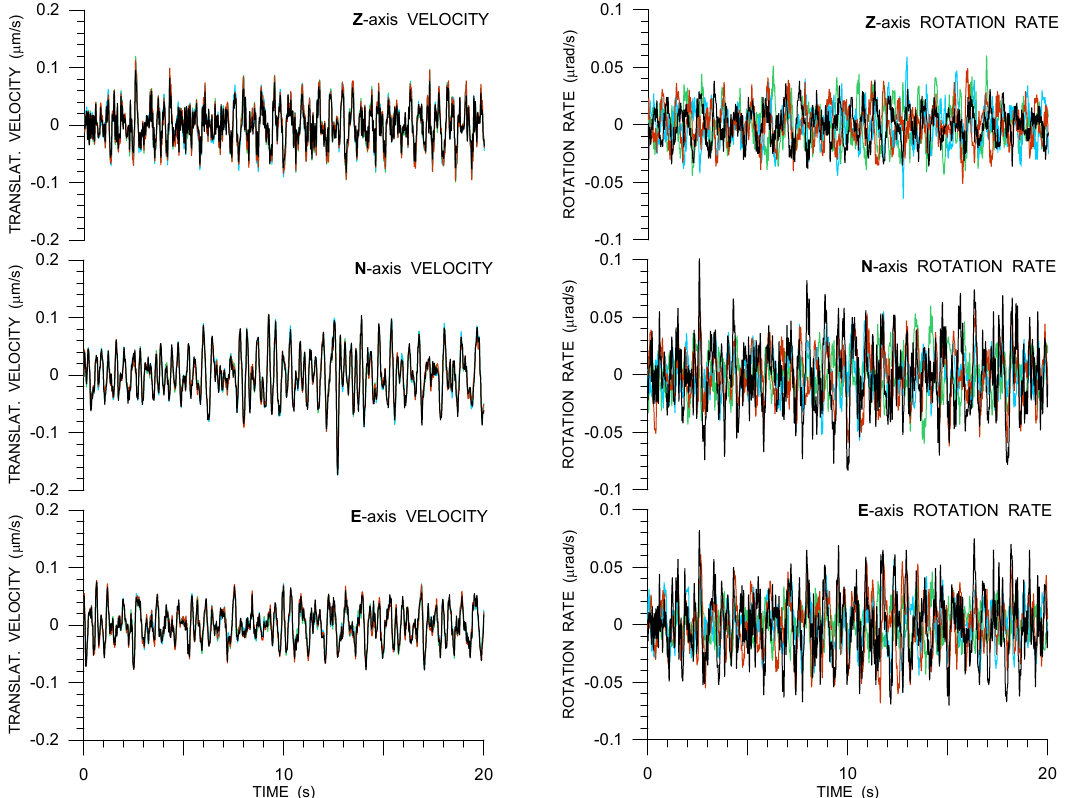
Figure 3. Twenty seconds of overnight noise as recorded by four 6C Rotaphone-CY instruments (R8—red, R10—black, R11—light blue, and R13—green) in the huddle test. Table 2. Correlation coefficients of 6C records of overnight noise from Rotaphones R8, R10, R11, and R13. The coefficients for ground velocity along Z-, N-, and E- axes are shown above diagonals while those for rotation rates around each of the axes are shown below diagonals and highlighted in light gray. Z-axis N-axis